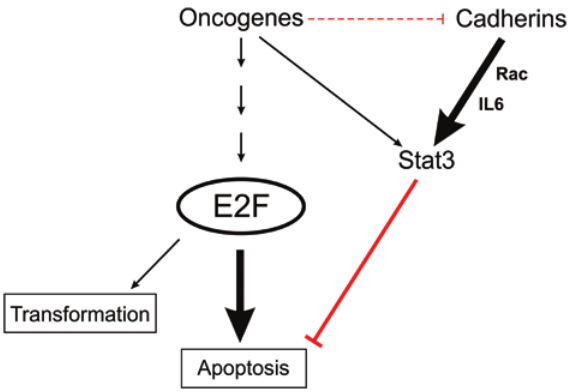
Figure 2: Model of Stat3 as a survival signal in cancer